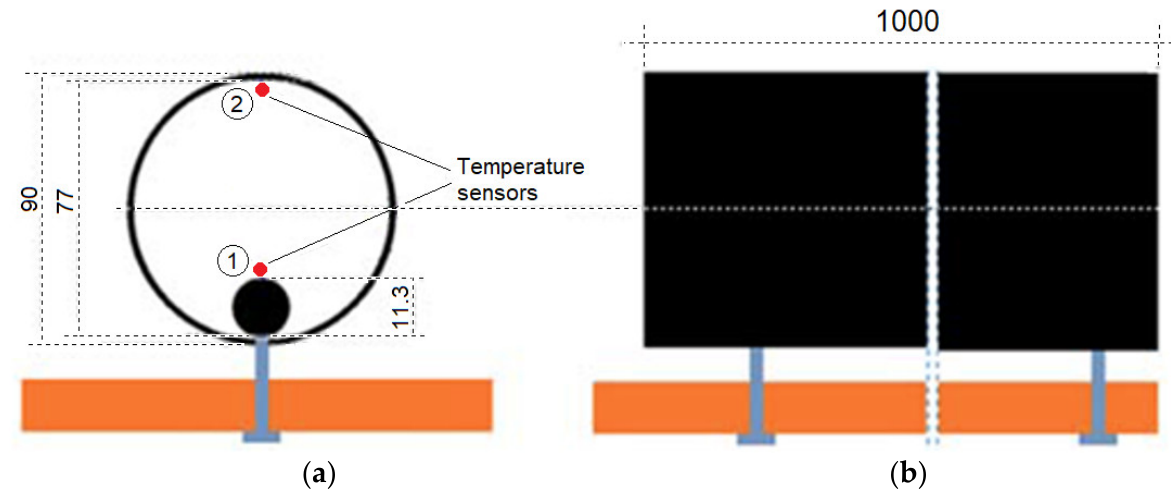
Figure 3. Attachment of the casing pipe and arrangement of sensors NTC 10 k in the pipe: ( a ) a cross-sectional view of the pipe; ( b ) a side view of a pipe section. The dimensions in the drawing are given in mm.